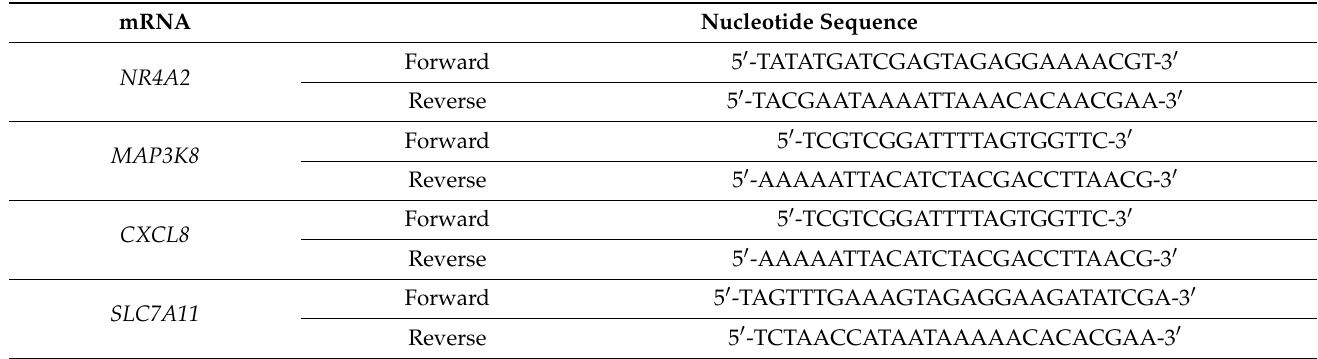
Table 7. The sequence of primers used in